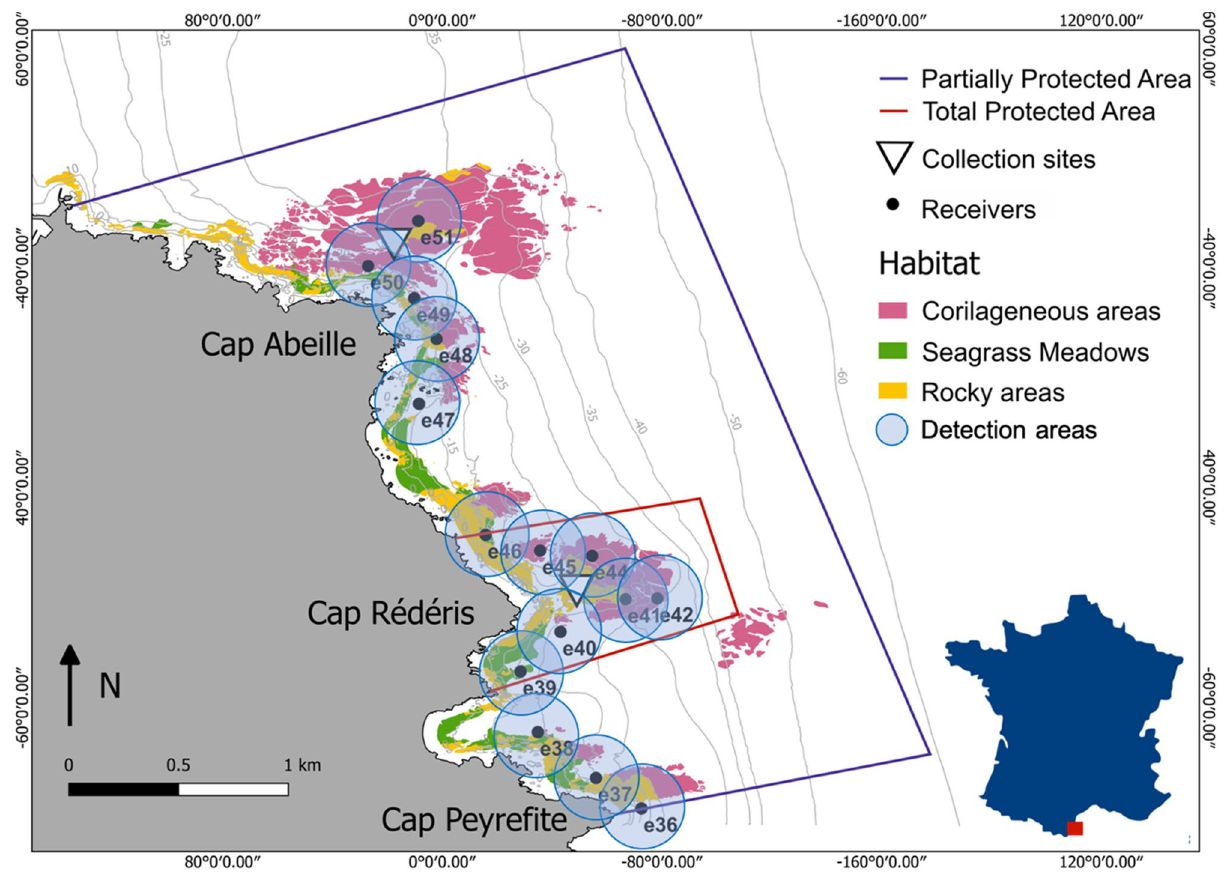
Figure 1. Study area and the acoustic receiver array within the RNMCB (Réserve Naturelle Marine de Cerbère- Banyuls), indicating the areas with different protection levels, the two collection sites (Close to Cap Abeille and Cap Rédéris), the receivers and their detection range (200 m) and the distribution of the main habitats types. Grey lines are bathymetric contours. The basic cartographic map and bathymetric data were provided by